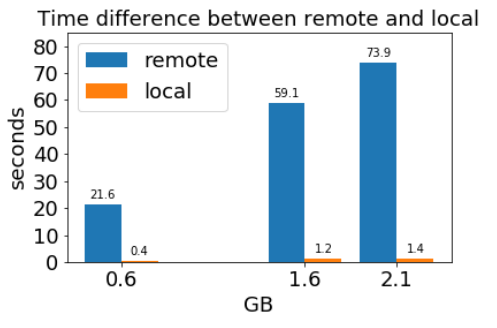
Figure 4. NFS performance. The orange bars show the time consumption of local filesystem reading, while the blue bars illustrate the time consumption of remote filesystem reading. The x -axis gives di ff erent file sizes.